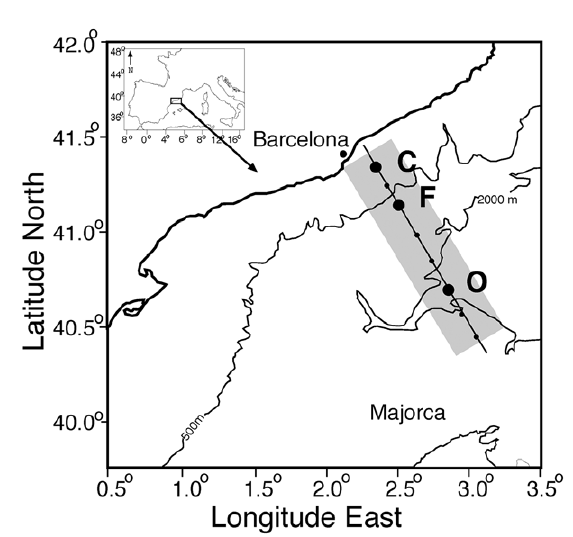
Fig. 1. – Map of the study area with the position of the hydrographic stations in the 120 km transect between Barcelona and the Majorca- Menorca channel (dots). Large black dots: coastal (C), frontal (F) and offshore (O) stations. Shaded rectangle: area occupied by the grid of CTD casts made to characterize the area hydrographically.